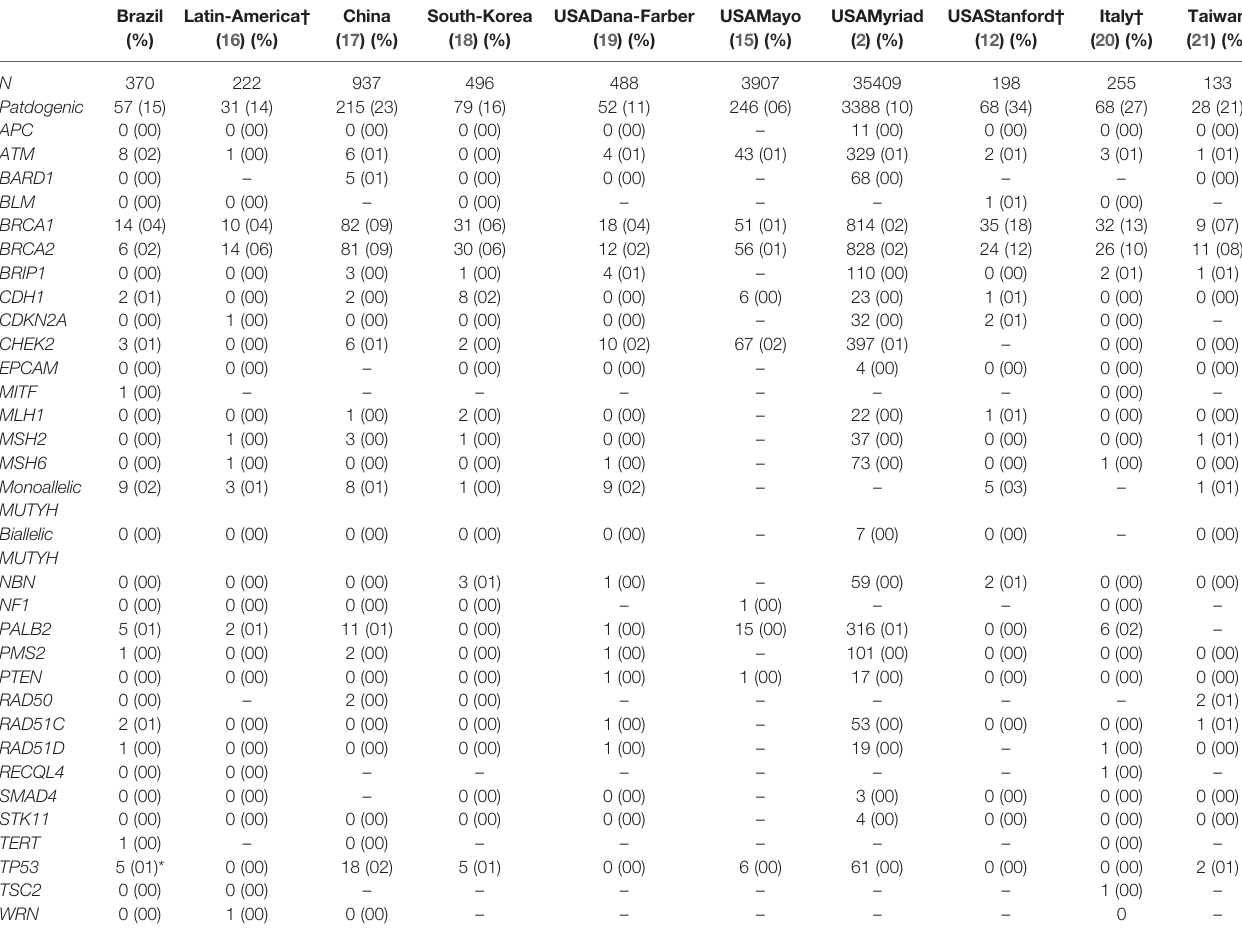
TABLE 5 | Prevalence and istribution of germline pathogenic variants in breast cancer patients from different populations. Brazil